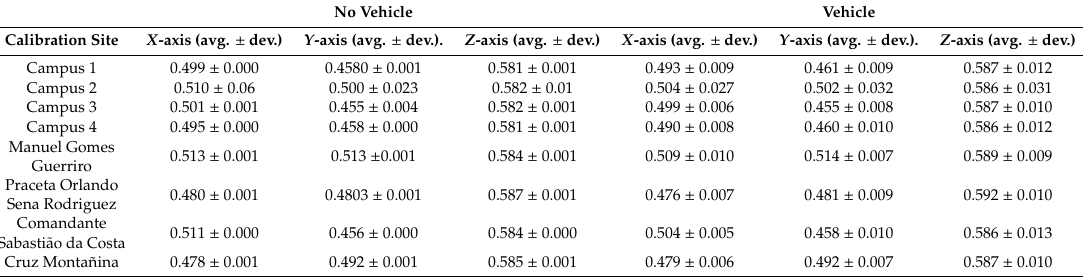
Table 2. Normalized average magnetic sensor measurements by location, axis and vehicle presence.